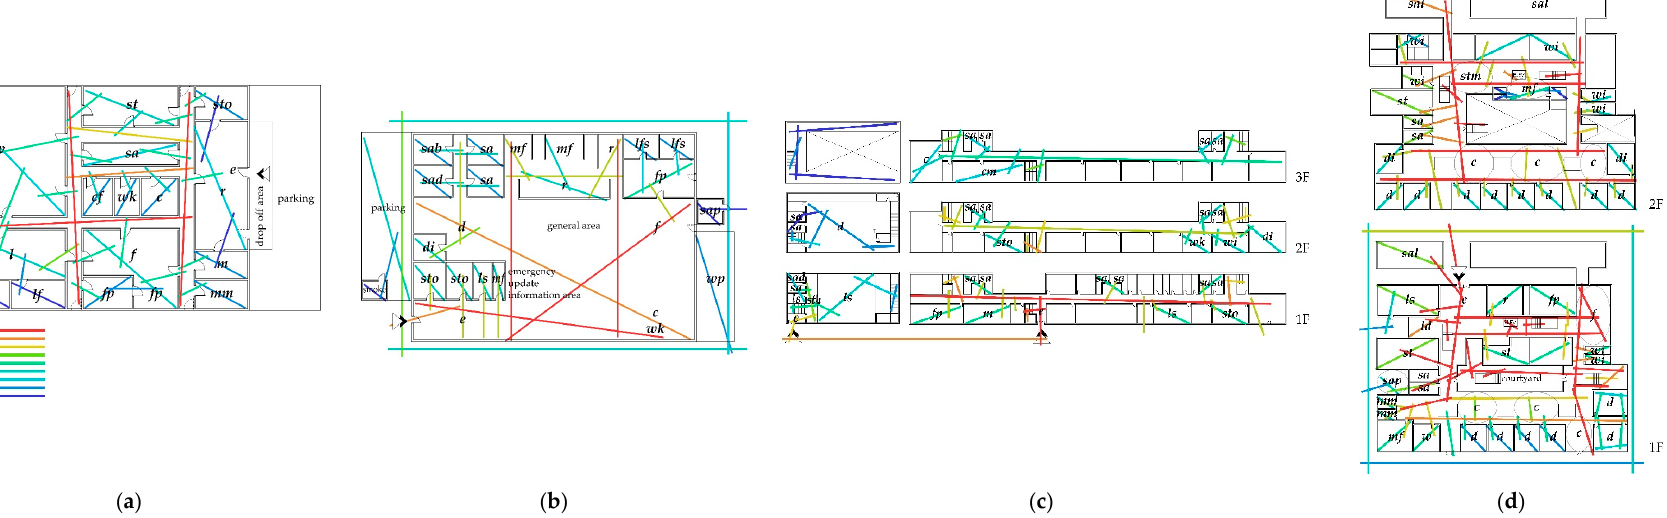
Figure 4. The axial line analysis results on cases (see Figure 2 for key to room functions): ( a ) case 1 (U.S.); ( b ) case 2 (AU); ( c ) case 3 (JP1); ( d ) case 4 (JP2).